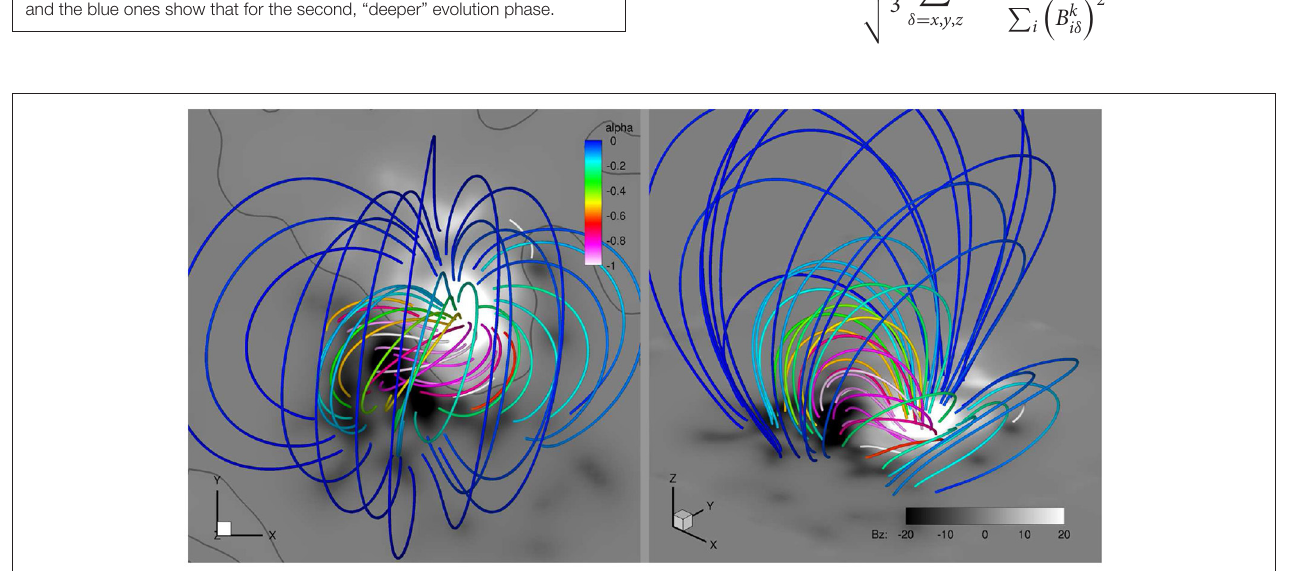
FIGURE 3 | 3D magnetic field of the MHD equilibrium based on the magnetogram taken for 00:00 UT on 2014 September 8. The thick lines are magnetic field lines and are pseudo-colored by value of the force-free parameter α . The background is shown with the magnetic flux distribution (i.e., B z ) on the bottom surface of the